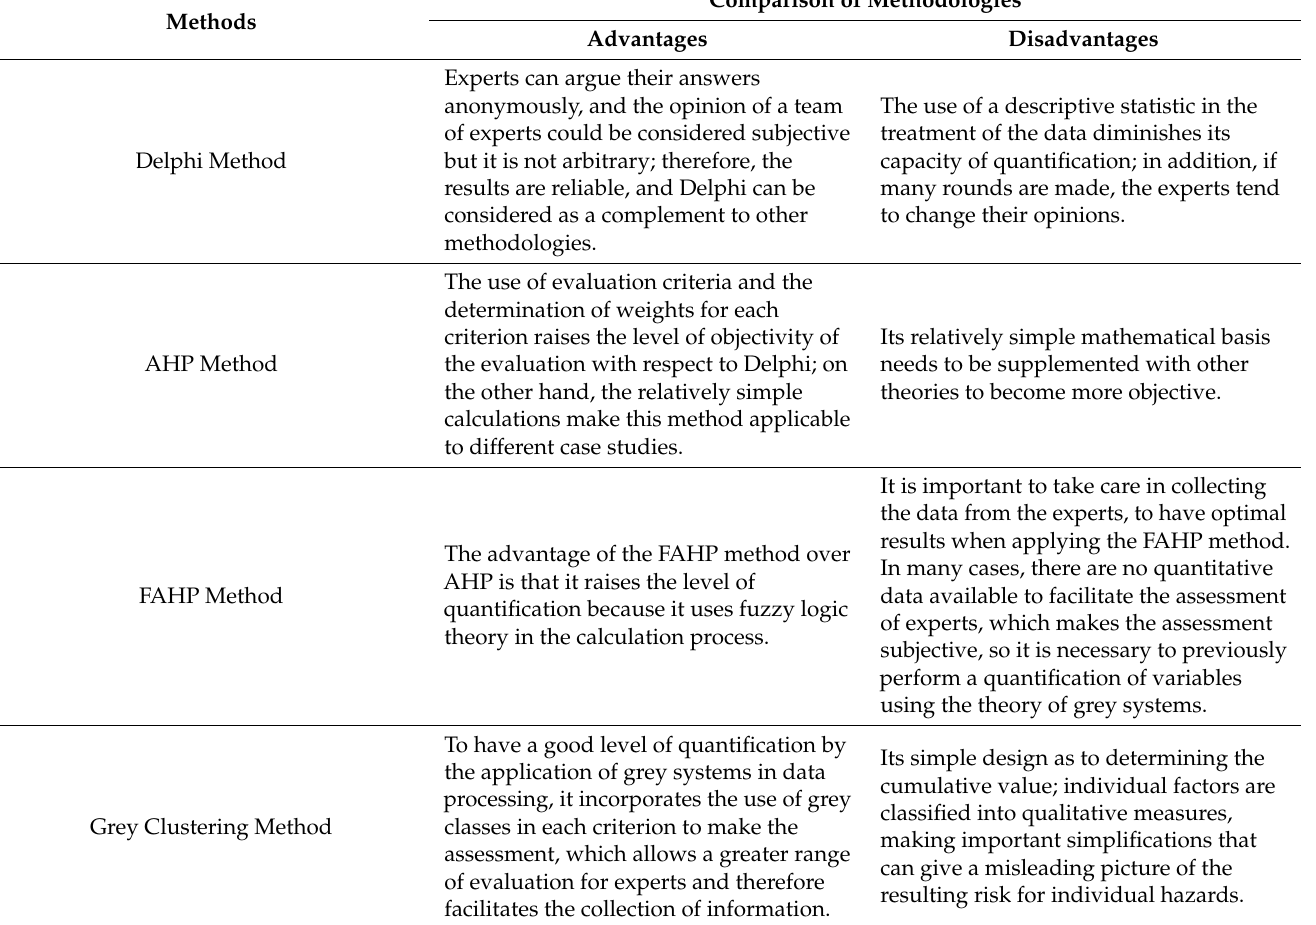
Table 16. Comparison of the grey clustering method with other